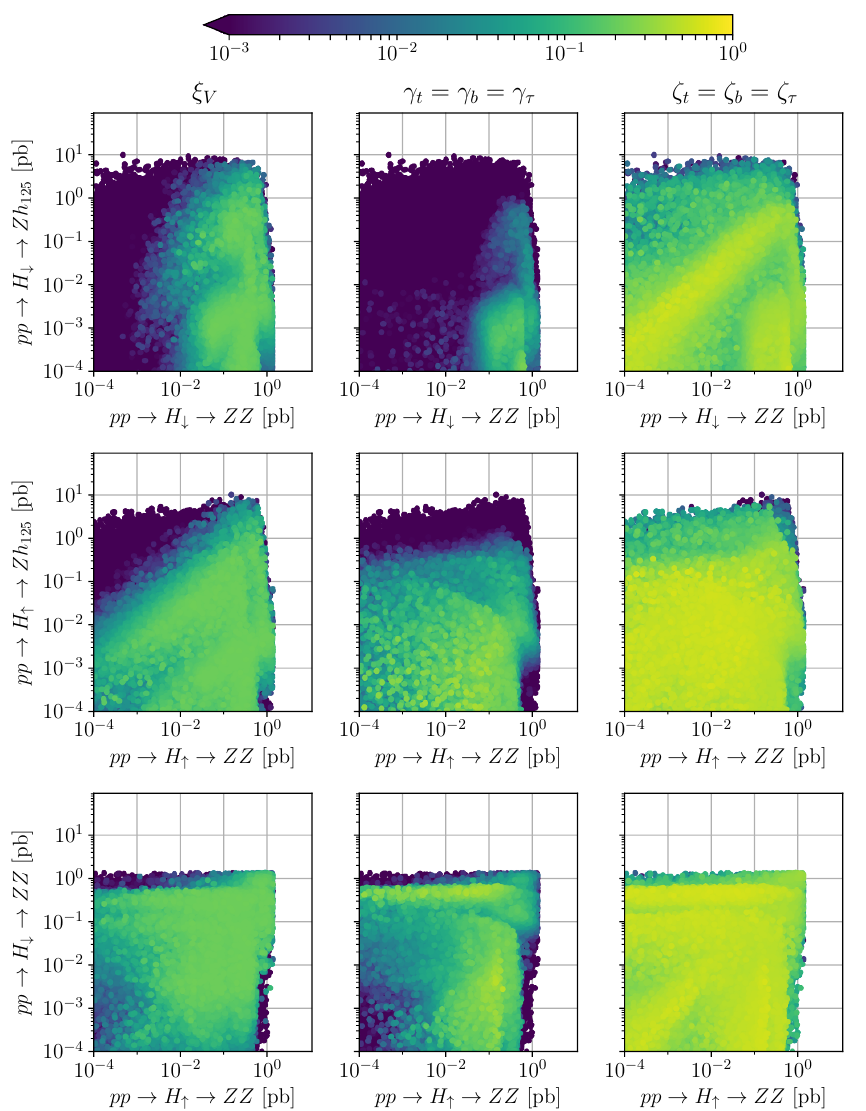
Figure 10 . Classes of CP-violating processes as a function of the CP-violating variables (see colour code) for the Type I C2HDM. In the (cid:12)rst row we show pp in the second row we have pp H Zh 125 against pp ! " ! plot pp H ZZ against pp H ZZ . In each column we show the variable that is being ! ! # ! " ! probed. The darker points are underneath the lighter